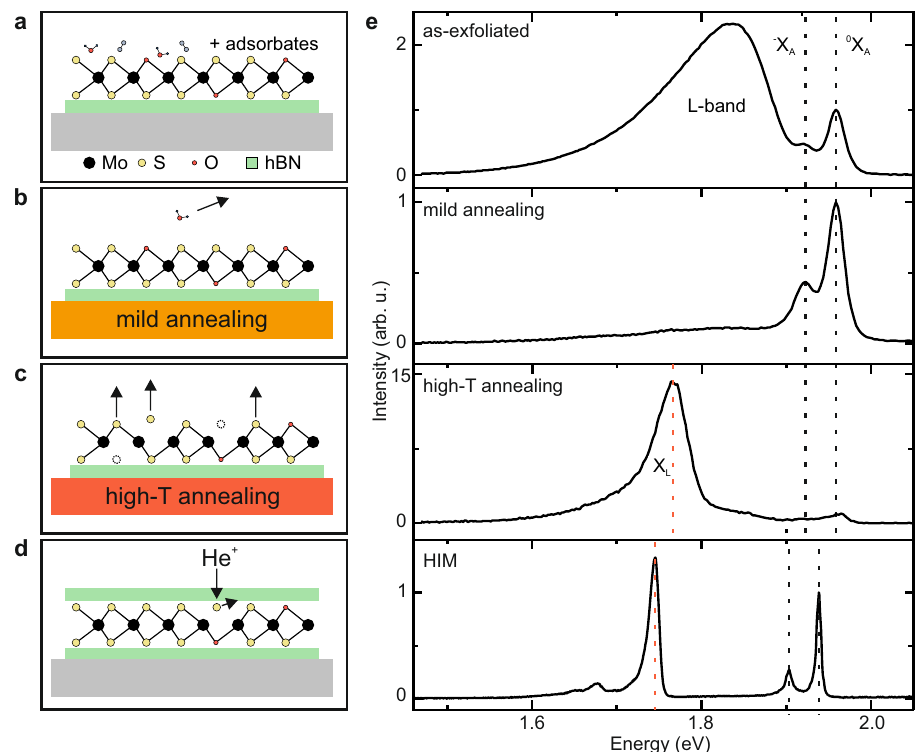
Fig. 1 Optical emission induced by adsorbates and engineered point defects in single-layer MoS 2 . a Schematic of as-exfoliated single layer MoS 2 on hBN (green) supported on a Si/SiO 2 substrate (gray). Black (yellow) dots denote molybdenum (sulfur) atoms. Red dots denote oxygen atoms, which are present either as part of adsorbates or as substitutional atoms on sulfur sites. b Heating the substrate to mild annealing temperatures ( T annealing < 500K, orange) removes the absorbates. c Heating the substrates to high annealing temperatures ( T annealing > 500 K, red) creates sulfur vacancies by thermal desorption (arrows). d Schematic of vacancy generation in MoS 2 fully encapsulated in hBN through He-ion (He + ) bombardment. e Evolution of low-temperature ( T ∼ 20 K) photoluminescence spectra. As-exfoliated MoS 2 exhibits a broad sub-gap luminescence (L-band) due to adsorbates. Mild annealing at T annealing = 500 K removes these adsorbates suppressing the L-band. Upon annealing at T = 800K, a narrow defect luminescence at 1.75eV emerges (X annealing L ), due to the thermal generation of sulfur vacancies with well-de fi ned in-gap states. Vertical, dashed lines indicate the emission energy of the neutral exciton ( 0 X A ), the trion ( − X A ), and X L . The intensities are normalized to the exciton transition 0 X A . Helium-ion (He + ) irradiation of MoS 2 encapsulated in hBN using a helium ion microscope (HIM) generates a similar defect feature at 1.75eV ( T = 4.2